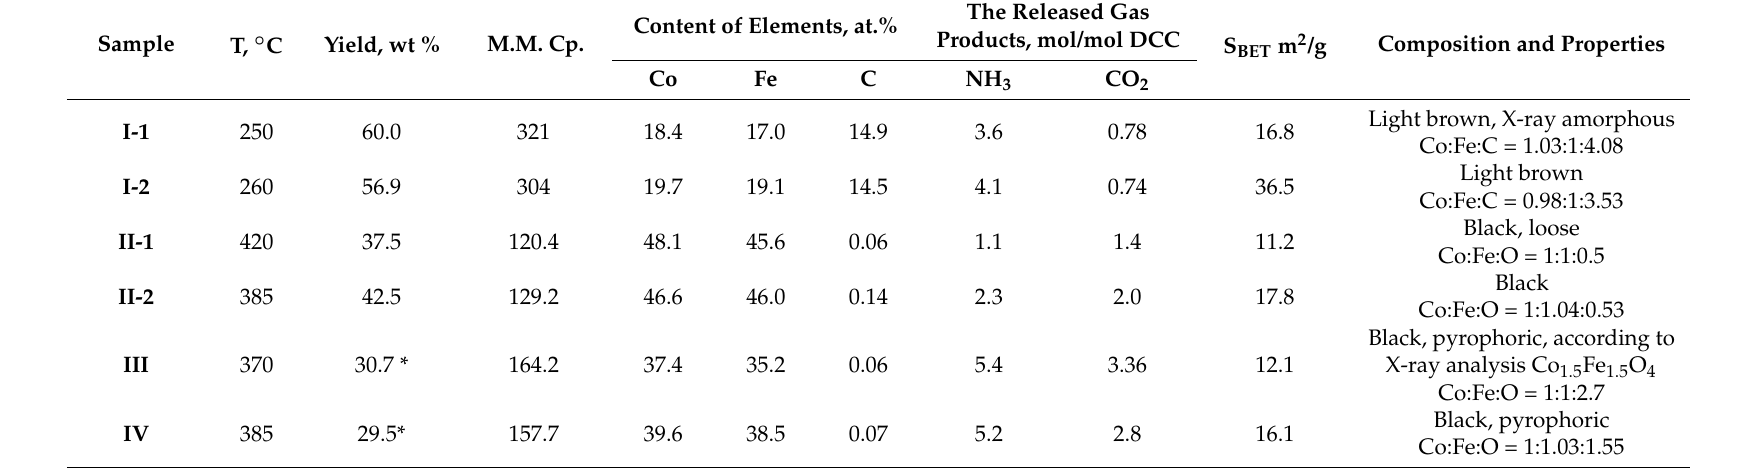
Table 2. Results of macroscopic